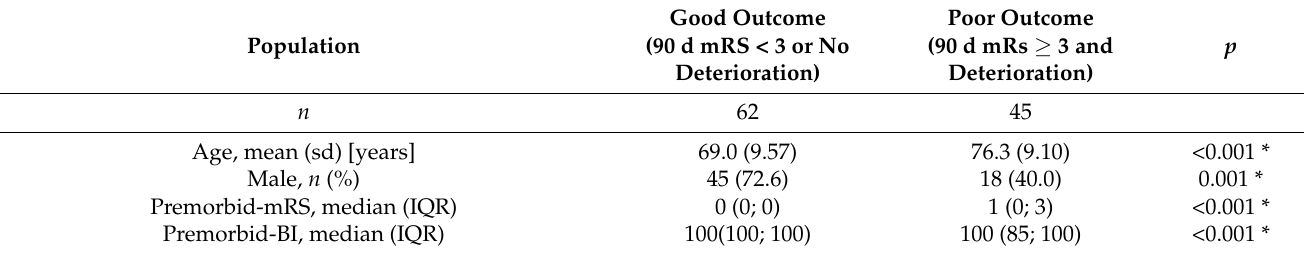
Table 1. Baseline